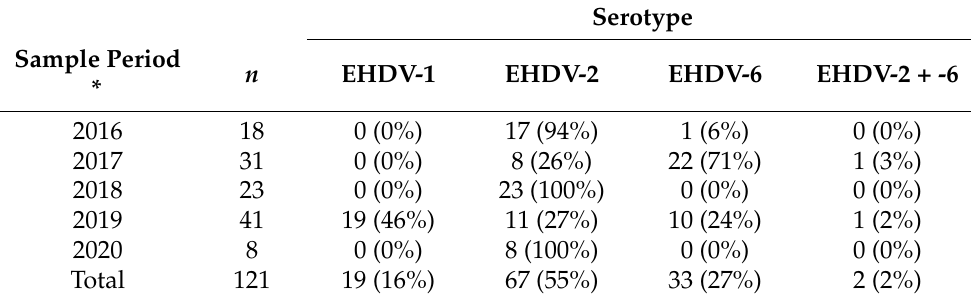
Table 3. Epizootic hemorrhagic disease virus (EHDV) serotypes identified from dead white-tailed deer on Florida deer farms by the Cervidae Health Research Initiative (University of Florida)